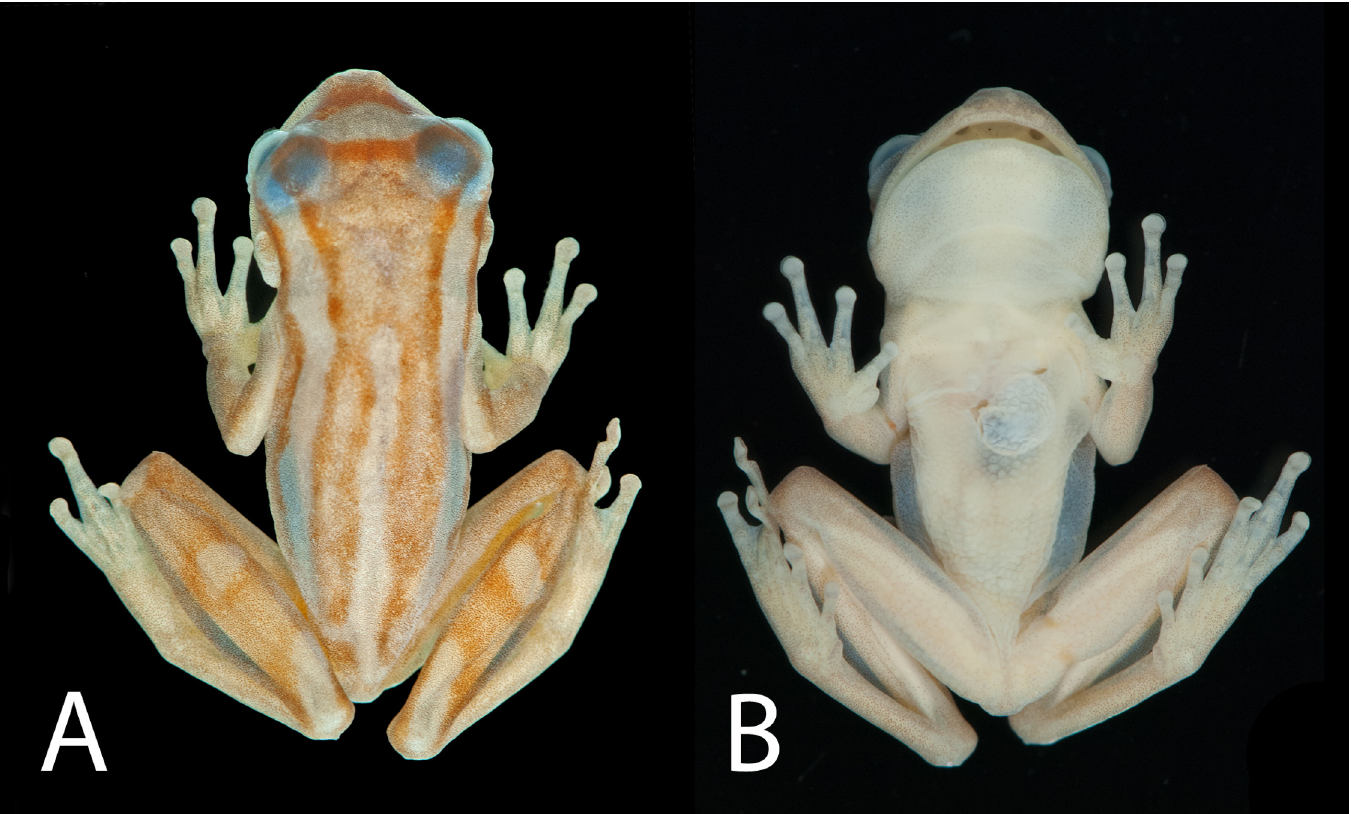
Fig 1. Holotype of Dendropsophus bromeliaceus sp. nov.. (A) Dorsal and (B) ventral views (MNRJ 85852, SVL 16.7 mm).